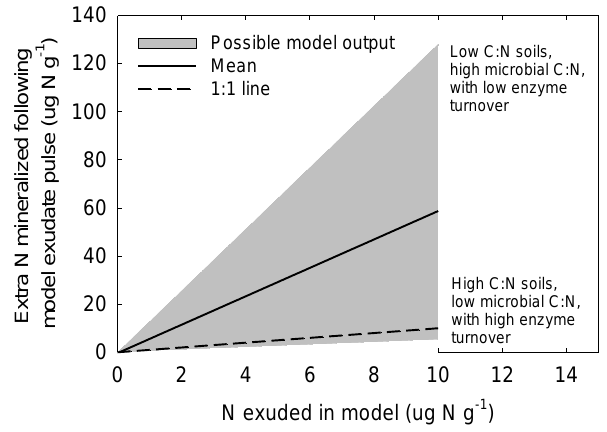
Fig. 3. Model results of the additional N mineralized following ex- udate pulses of varying N content. The cumulative extra N miner- Figure 3. Model results of the additional N mineralized following exudate pulses of varying N alized following an exudate pulse increased with increasing N exu- content. The cumulative extra N mineralized following an exudate pulse increased with dation (solid line, y = 5.9 x − 0.4) and was generally above the 1 : 1 increasing N exudation (solid line, y = 5.9x – 0.4) and was generally above the 1:1 line (dashed line). N exudation increased exo-enzyme activity which released N from SON. The grey area line (dashed line). N exudation increased exoenzyme activity which indicates possible model output, depending on parameter values. released N from SON. The grey area indicates possible model out- put, depending on parameter